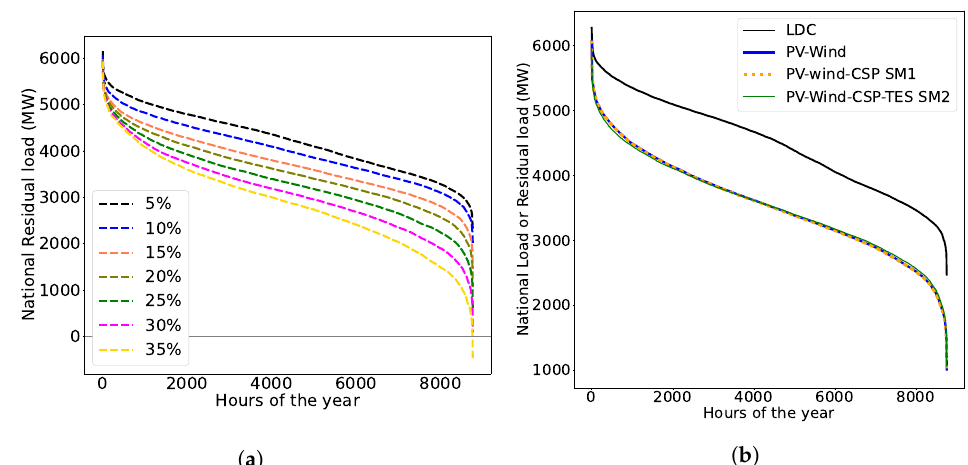
Figure 12. ( a ) RLDC for different penetrations illustrating the variation of the RLDC parameters (peak, mid and base load) with increasing penetrations and the renewable share threshold at which curtailment occurs for PV–wind–CSP-TES SM2 combination. ( b ) LDC and RLDC for different combinations, computed at 20% penetration (risk-as-actual mix) for the global strategy (2) with maximum-cost constraint (5), illustrating the system flexibility provided by